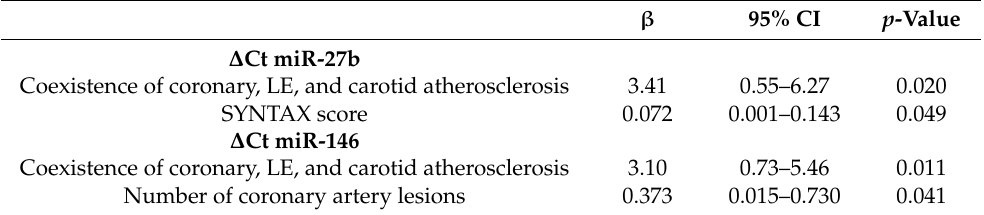
Table 3. Parameters associated with miR-27b and miR-146 expression levels in multivariate linear regression analysis.